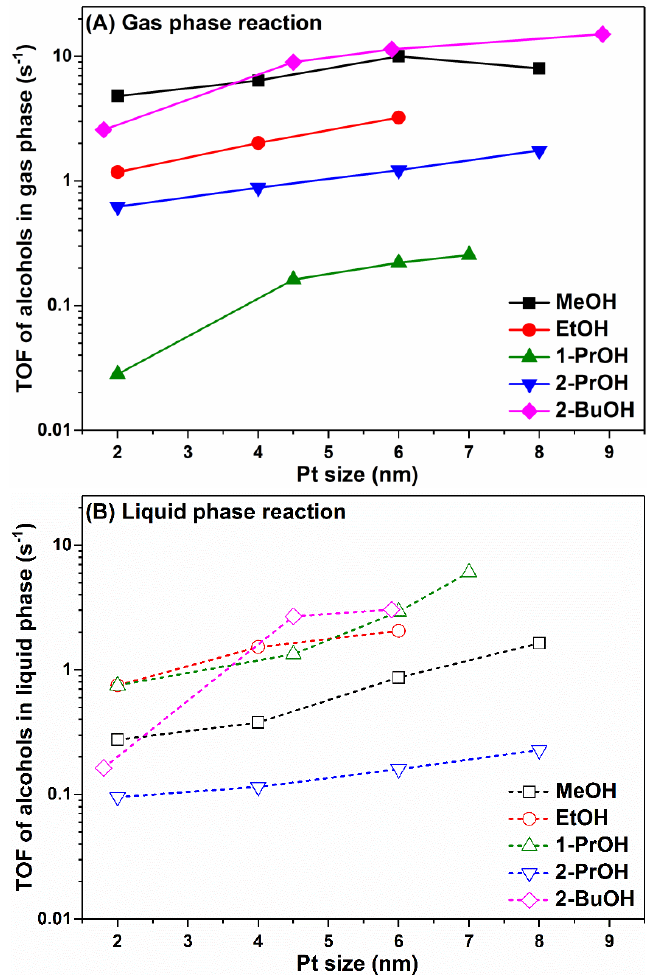
Figure 2. Size effect of Pt nanoparticles on TOF values of MeOH, EtOH, 1-PrOH, 2-PrOH oxidation at 60 °C and 2-BuOH oxidation at 80 °C. ( A ) Gas phase reaction: 1.33 kPa alcohol, 6.67 kPa O 2 , 94.66 kPa He; ( B ) Liquid phase reaction: 15 mL alcohol, dissolved oxygen under 100 kPa (300 kPa for 2-BuOH). (TOF data for MeOH, EtOH, 1-PrOH, 2-PrOH, 2-BuOH oxidations as a function of Pt nanoparticle sizes were reported in [9,19–22], respectively).